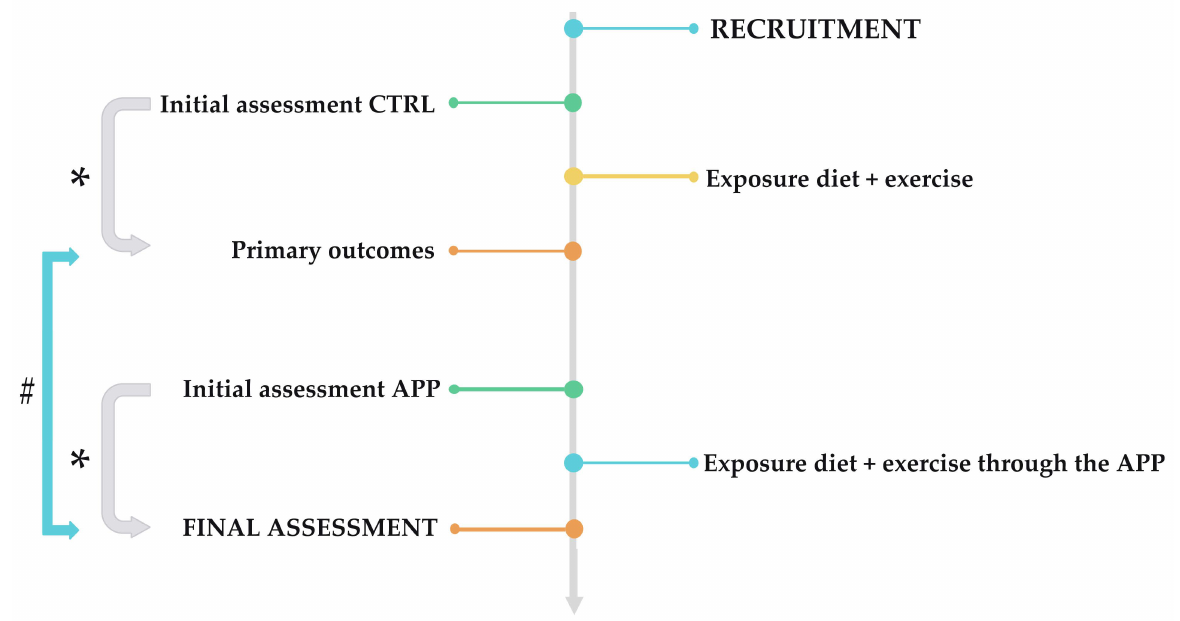
Figure 1. Clinical trial design. * = study if there are intra-period differences; # = study if there are inter-period differences. CTRL = control. app = mobile